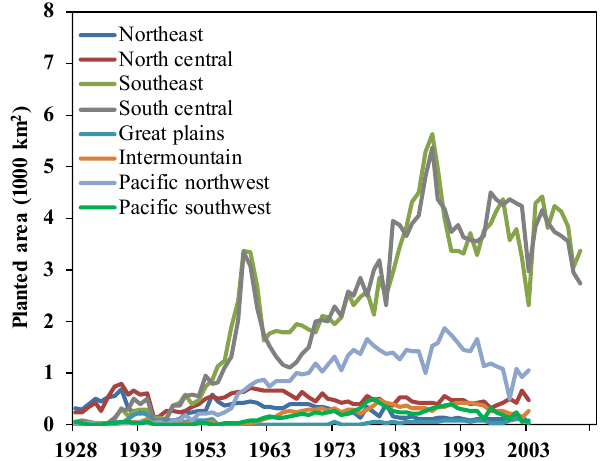
Figure 5. Interannual variations in planted tree area (1000km 2 yr − 1 ) for eight subregions in the CONUS during 1928–2011 (data source: Oswalt et al., 2014). Note that the data for the Southeast and South Central are extended to 2011, while the continuous inventory data end in 2003 and resume in 2011 for other